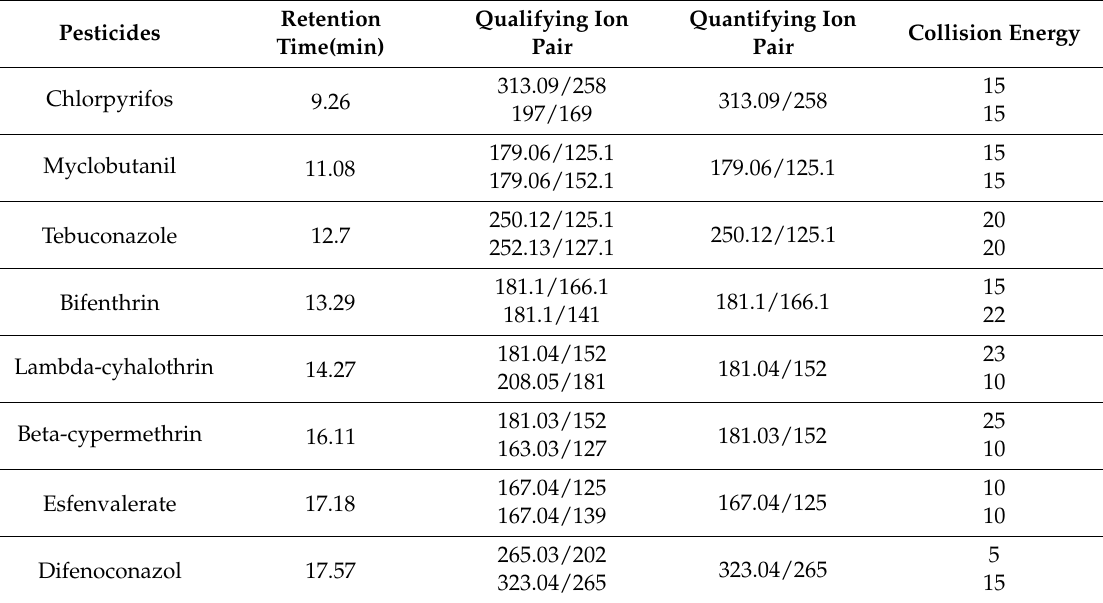
Table 2. GC-MS/MS condition for the identification and quantitation of eight pesticides.